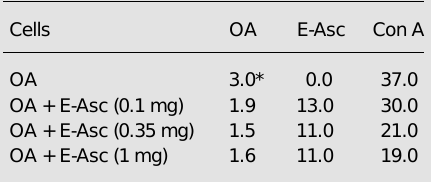
Table 2. Proliferative response of lymph node cells from mice immunized with ovalbumin (OA) or OA plus Ascaris suum egg extract.